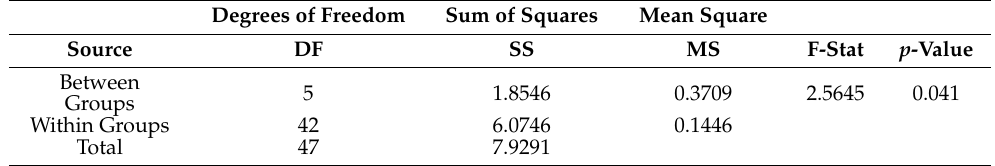
Table 3. Comparison of Contexts for Low Sensitivity Questions.